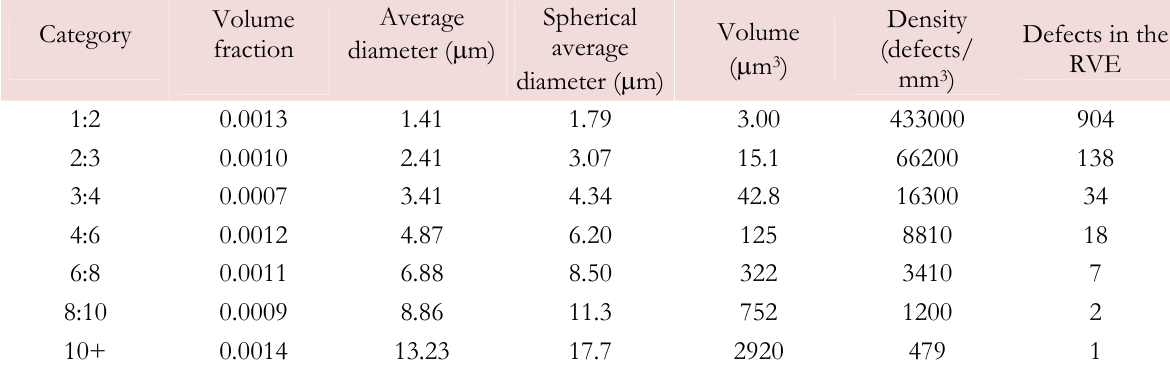
Tabella 2: Defects distribution in the RVE (from Tab. 1 data